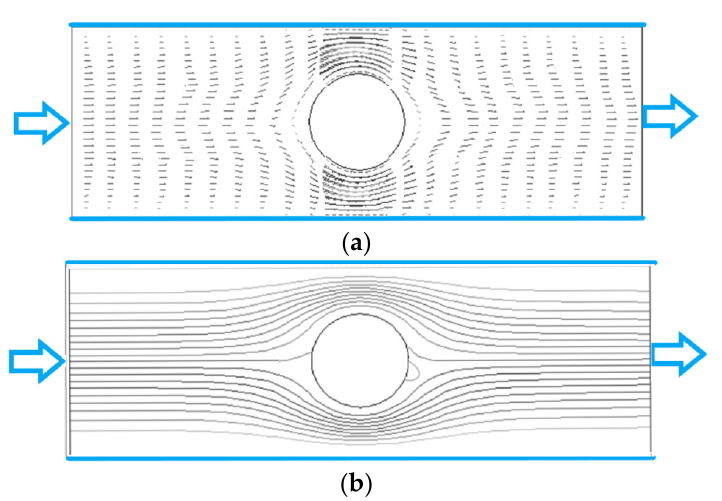
Figure 5. Fluid velocity vector and streamline of flow (Re = 200, n = 1.3). ( a ) velocity vector. ( b )